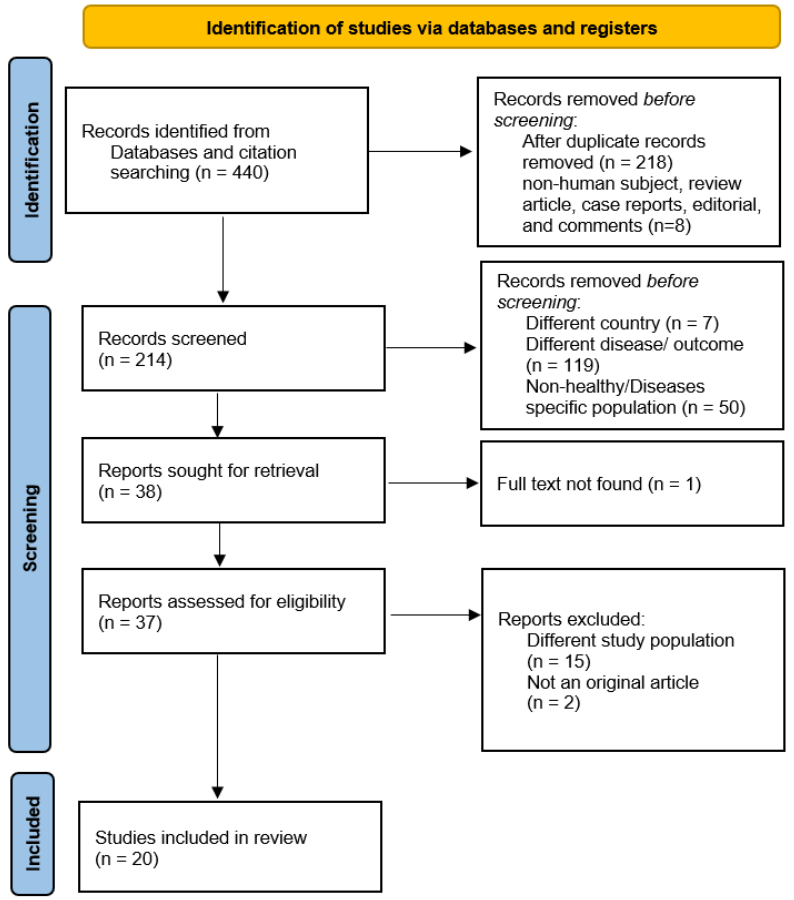
Figure 1. Flow Chart showing the search strategy and selection of studies. Adapted from Ref. [33]. For more information, visit: http://www.prisma-statement.org/ (accessed on 6 February 2023).